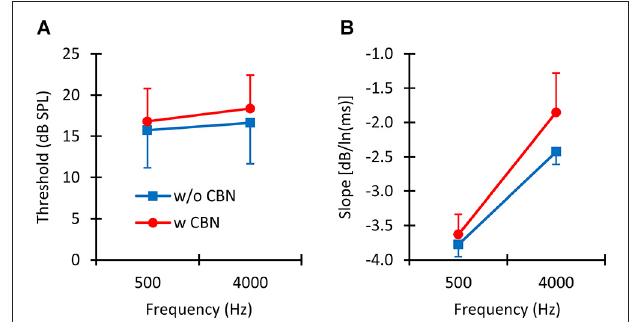
FIGURE 4 | The mean effect of contralateral stimulation . (A) Mean absolute detection thresholds with (w CBN) and without (w/o CBN) contralateral stimulation at the two test frequencies. (B) Mean slope of the threshold-vs.-duration functions with and without contralateral stimulation at the two test frequencies. Error bars illustrate one standard deviation.